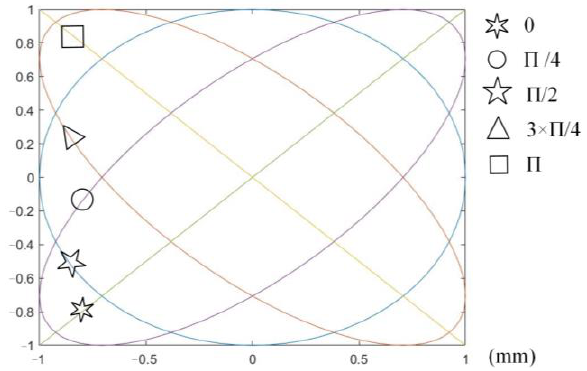
Figure 2. Single-cycle cutting trajectory.